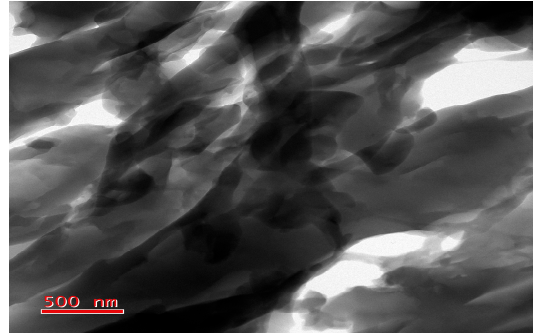
Figure 4. TEM image of TRGO (0.2 wt%)/epoxy composite.